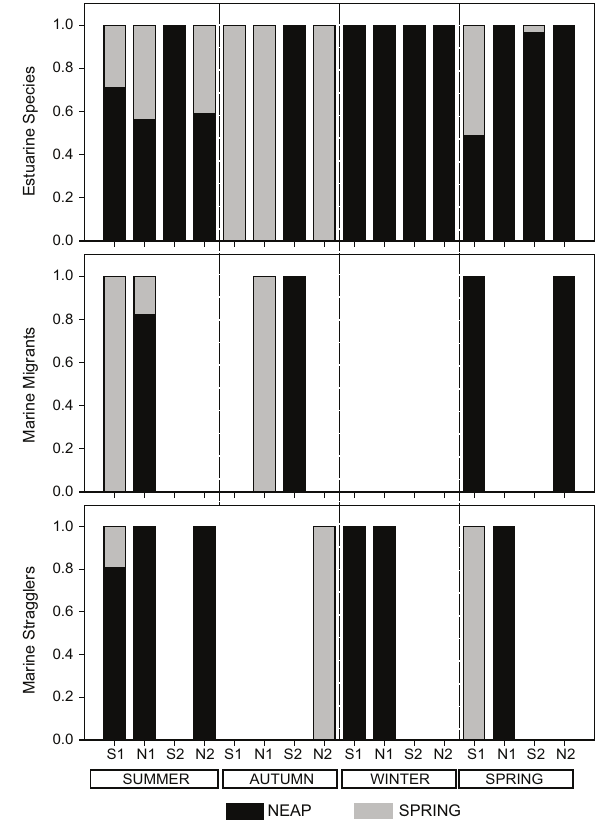
Fig. 6 . – Seasonal and spatial relative density of the three main eco- logical guilds during the 2 lunar-cycle Table 3. – Mean density (ind. 100 m -3 ) of the main ichthyoplankton species in each ecological guild identified in Mondego estuary for each season, lunar-tide cycle (neap and spring) and sampling station and results from 2-way univariate PERMANOVA (pseudo-F values) analysis.